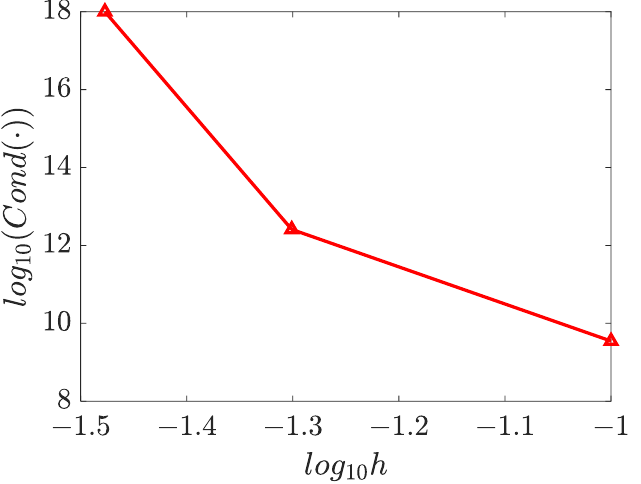
Figure 6. Convergence of wave number for the 1D constant parameter identification problem.